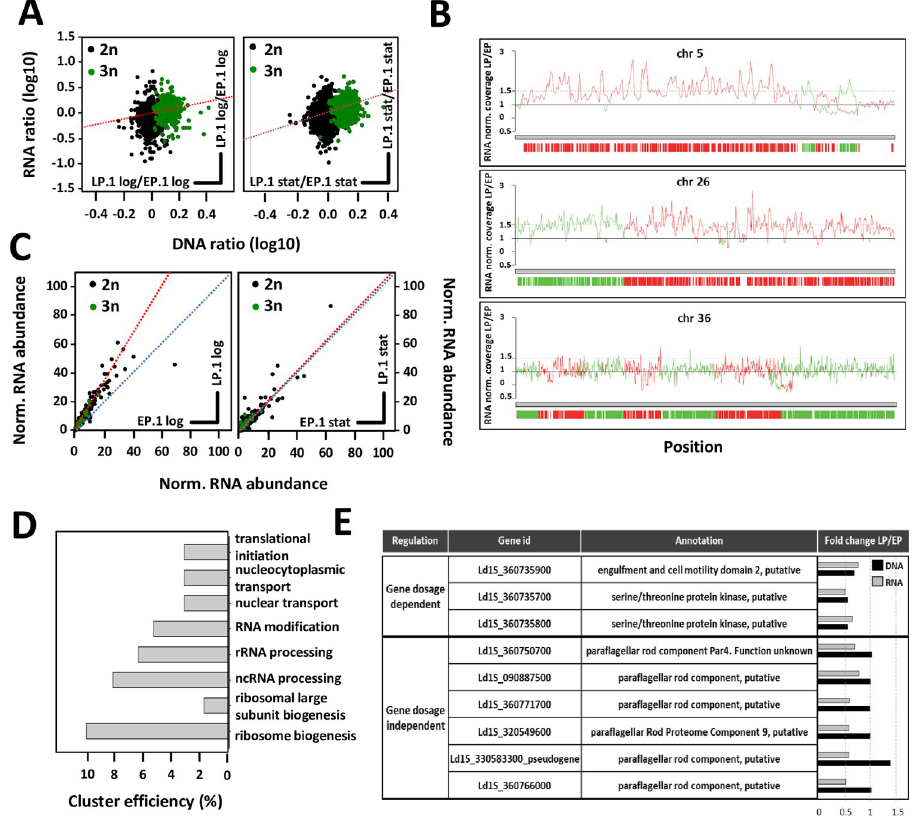
Fig 3. RNA abundance during fitness gain in culture is regulated by gene dosage and post-transcriptional mechanisms. (A) Ratios of DNA and RNA normalized read counts for all genes were plotted for LP.1 log compared to EP.1 log (left panel) and for LP.1 stat compared to EP.1 stat (right panel). Green dots correspond to genes encoded on trisomic chromosomes in LP.1 parasites. The regression line is represented by the dotted red line. Pearson correlation coefficients and p-values were estimated for both ratio plots using SigmaPlot software. For LP.1 log compared to EP.1 log: ρ = 0.341 and p-value < 10 − 10 . For LP.1 stat compared to EP.1 stat: ρ = 0.333 and p-value < 10 − 10 . (B) Normalized coverage based on the ratio of DNA read counts in LP.1 versus EP.1 for the trisomic chromosomes 5 (upper panel) and 26 (middle panel), and the disomic chromosome 36 (lower panel). The coverage ratio is indicated by the lines, while ORFs are indicated by the vertical bars. The color code reflects the DNA strand on which the ORFs are encoded (see Sheets f and h in S5 Table). (C) Post-transcriptional regulation of transcript abundance. RNA read counts were normalized by DNA read counts and plotted for all genes in LP.1 log compared to EP.1 log (left panel) and EP.1 stat compared to LP.1 stat (right panel). Green dots correspond to genes encoded on trisomic chromosomes in LP.1 (see Sheets a and c in S5 Table). The calculated (red) and expected (blue) regression lines are represented. (D) Cluster efficiency computed from GO term-enrichment analysis for the ‘biological process’ category for 659 gene dosage- independent genes. Transcripts with adj. p-value < 0.01 were considered to determine the ratio of ‘normalized RNA abundance in LP.1/RNA normalized abundance in EP.1’ (see Sheet I in S5 Table for details). Cluster efficiency was calculated based on 274 genes with GO IDs out of the 659 genes that showed at least a 1.2-fold increase in LP.1 normalized RNA abundance compared to EP.1. Only the functional enrichments associated with adj. p-value < 0.05 were considered. (E) Table listing selected gene dosage-dependent and -independent expression changes (from Sheets d and e in S5 Table). The fold change values computed from RNA (grey bars) and DNA (black bars) normalized read counts for LP.1 versus EP.1 log parasites are